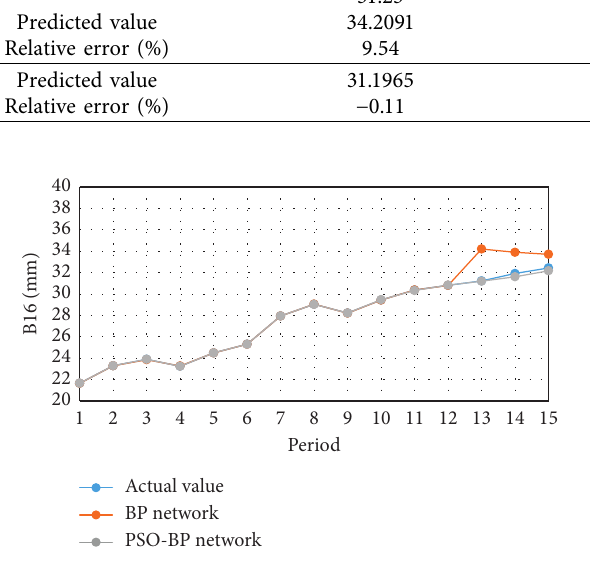
Figure 23: Comparison of the actual and predicted